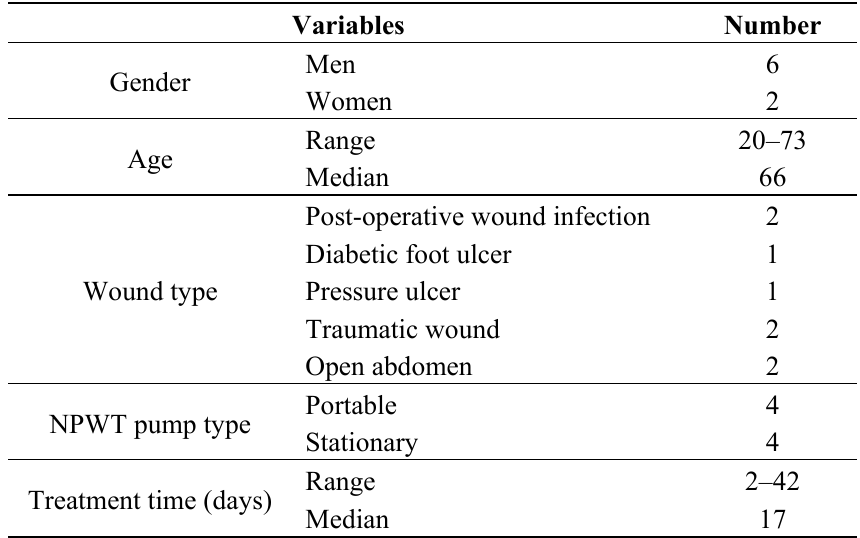
Table 1. Demographic and medical data of the participants ( n = 8). NPWT, negative pressure wound